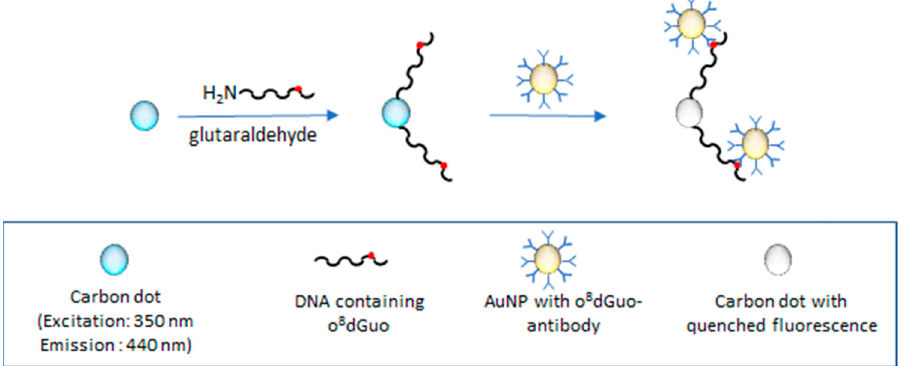
Figure 8. Fluorometric immunoassay using carbon quantum dots (CQDs) for the detection of DNA containing o 8 dGuo lesion [36].